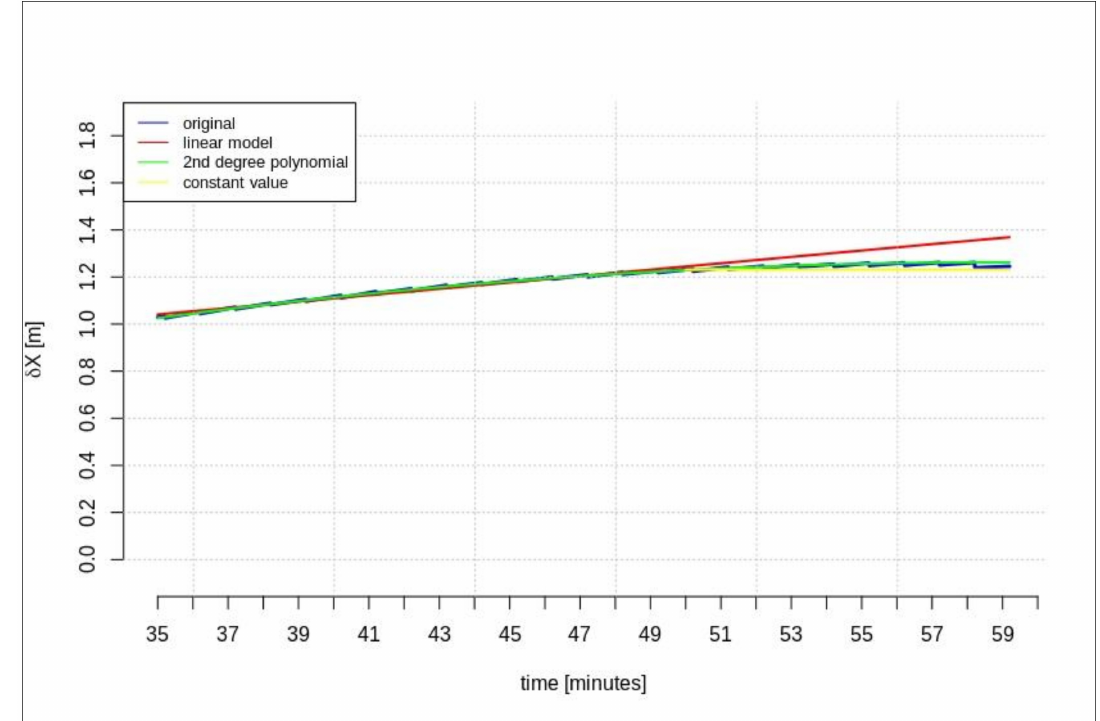
Figure 14. The results of the δ X geocentric correction extrapolation (GPS G28) for a 15-min data-stream between each IODE.